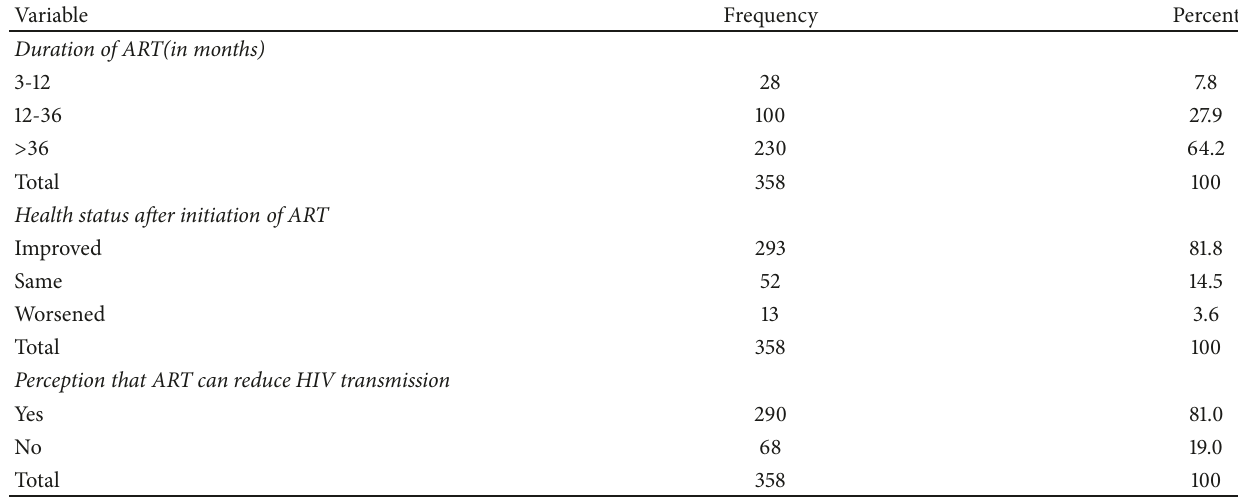
Table 2: ART related characteristics of HIV infected persons in condom use survey, Kollidiba health center, North West, Ethiopia,